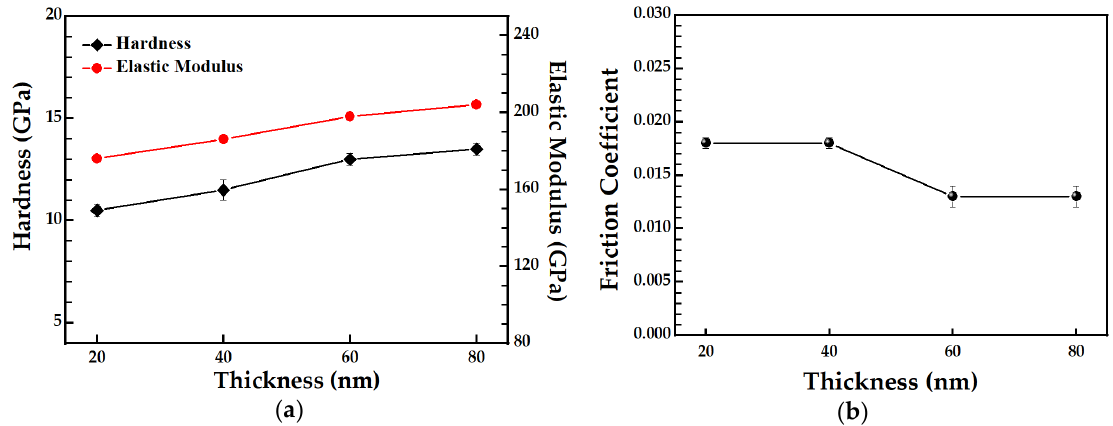
Figure 2. ( a ) Hardness and elastic modulus, and ( b ) friction coefficient in the RF-PECVD DLC thin films with various film thicknesses: 20, 40, 60, and 80 nm.